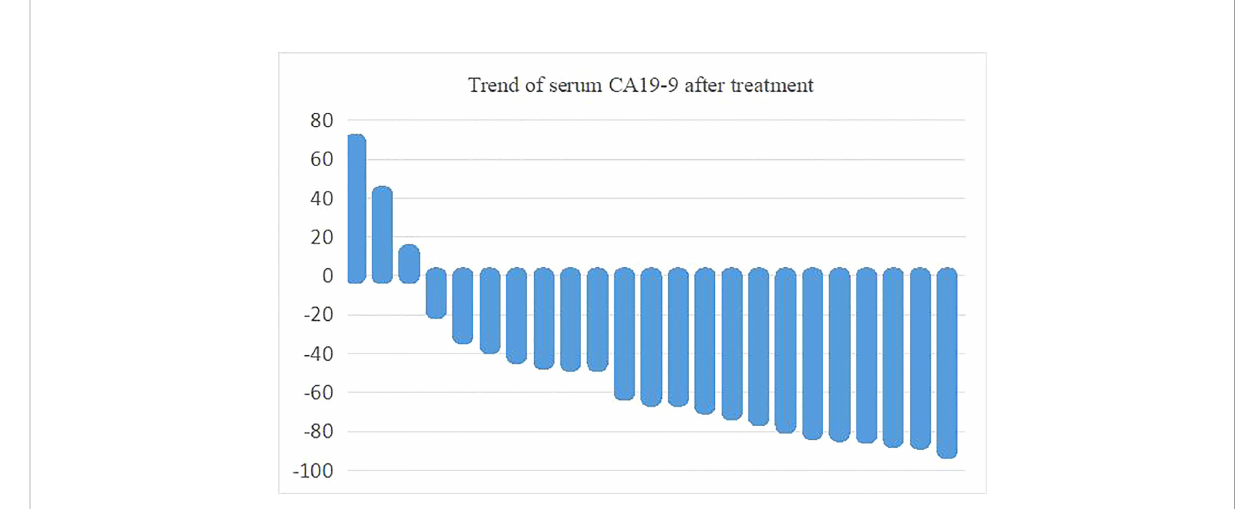
FIGURE 5 Trend of serum CA19-9 after